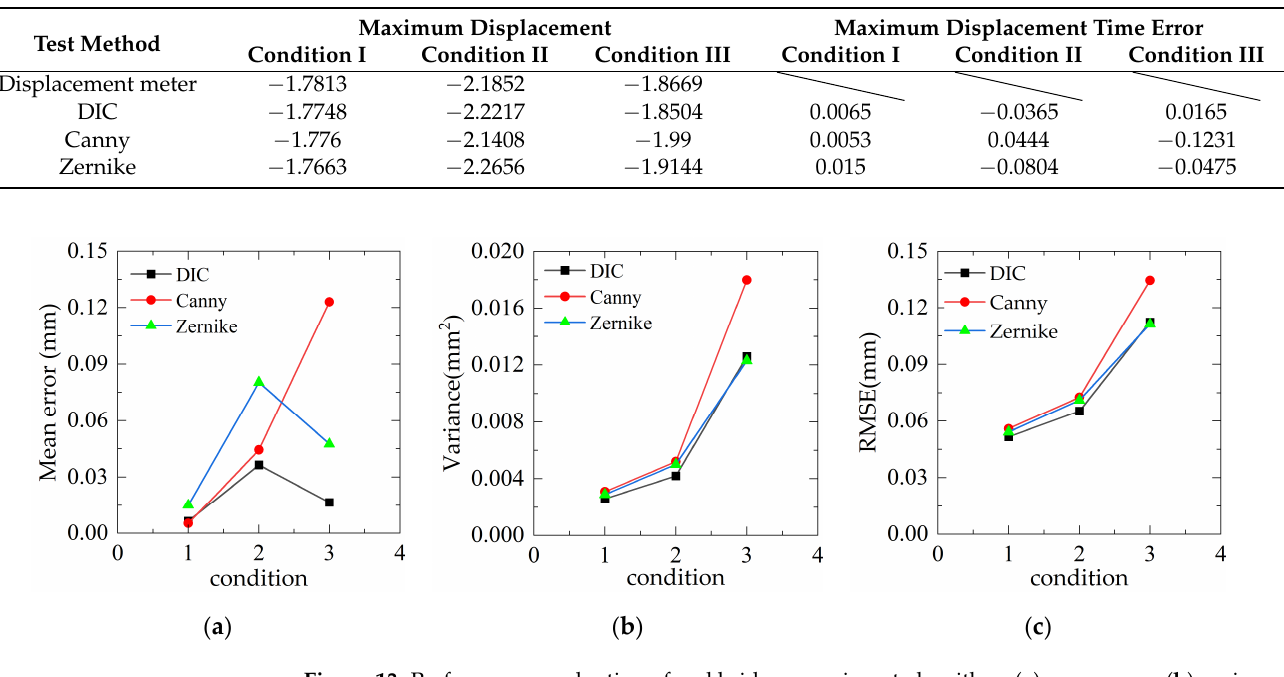
Figure 13. Performance evaluation of real bridge experiment algorithm: ( a ) mean error; ( b ) variance; and ( c ) mean square error. Table 2. Maximum value and error of bridge displacement.